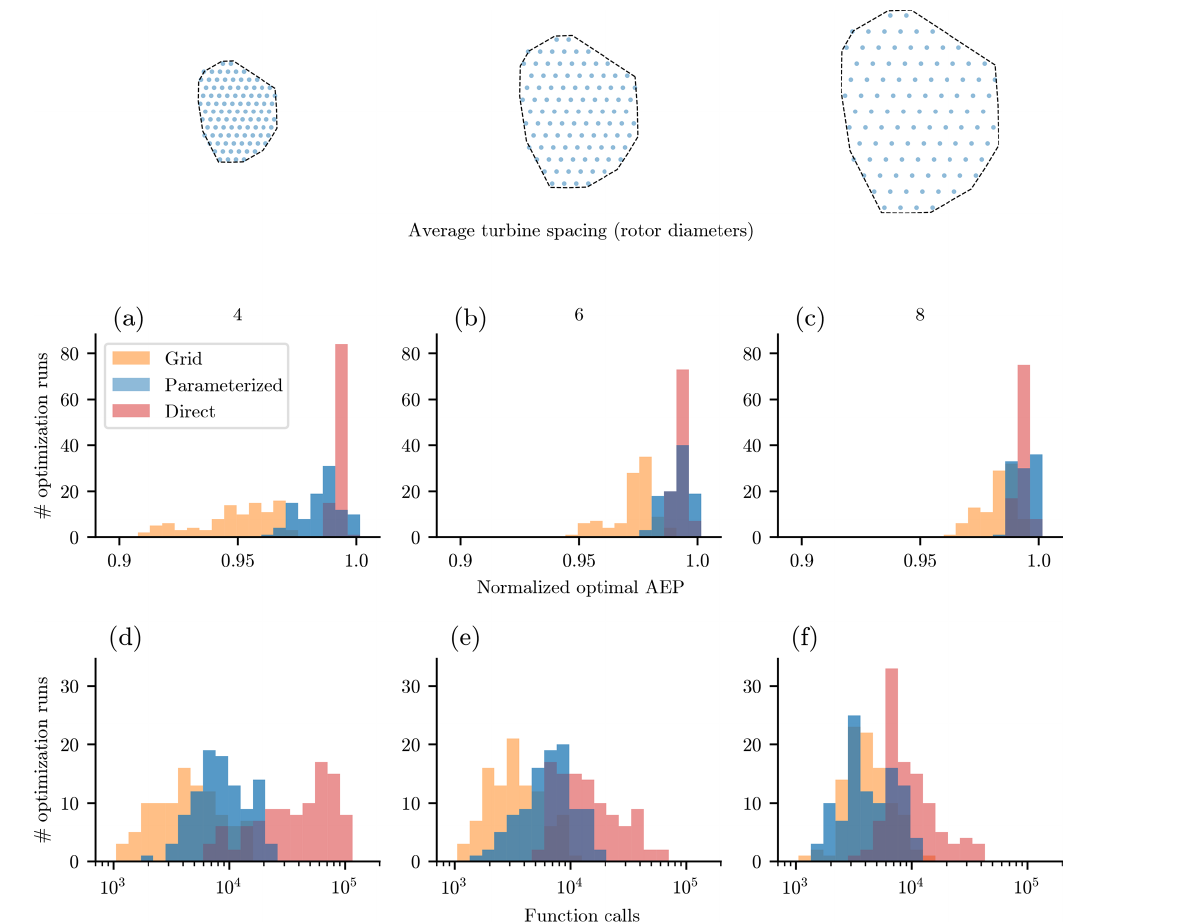
Figure 10. Results from 100 randomly initialized optimizations for wind farms with varied average turbine spacing and 100 wind turbines. The farm optimized had the Princess Amalia boundary and the wind rose from North Island, California. Shown are results using the grid turbine parameterization, our new boundary-grid parameterization, and direct optimization. The optimal annual energy production distribu- tion achieved for each of the optimization runs, in wind farms with varied turbine spacing of 4, 6, and 8 rotor diameters for panels (a) , (b) , and (c) , respectively. The number of function calls required to converge for each of the optimization runs, in wind farms with varied turbine spacing of 4, 6, and 8 rotor diameters for panels (d) , (e) , and (f) ,